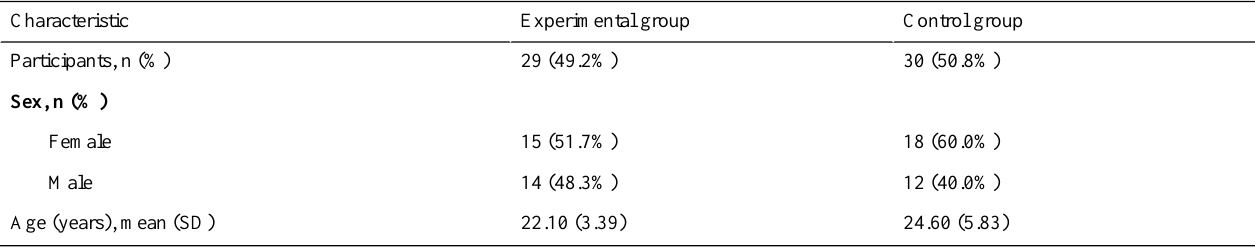
Table 1. Sociodemographic characteristics of the participants (N=59).